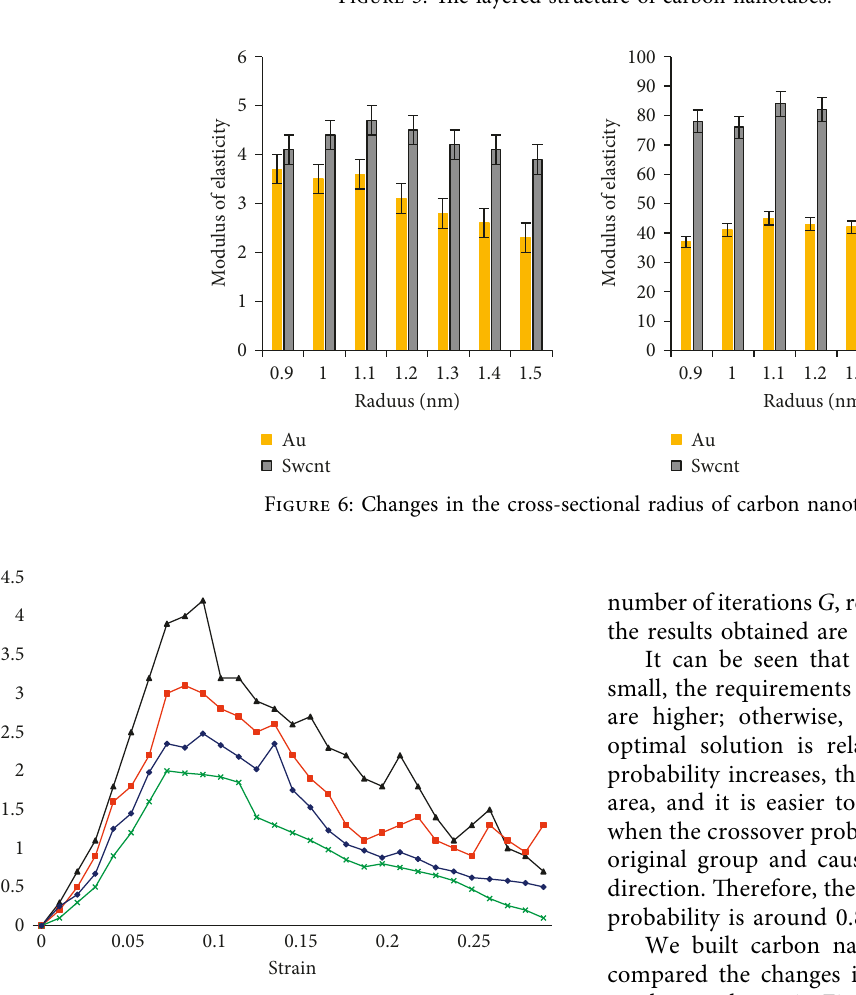
Figure 5: The layered structure of carbon nanotubes.